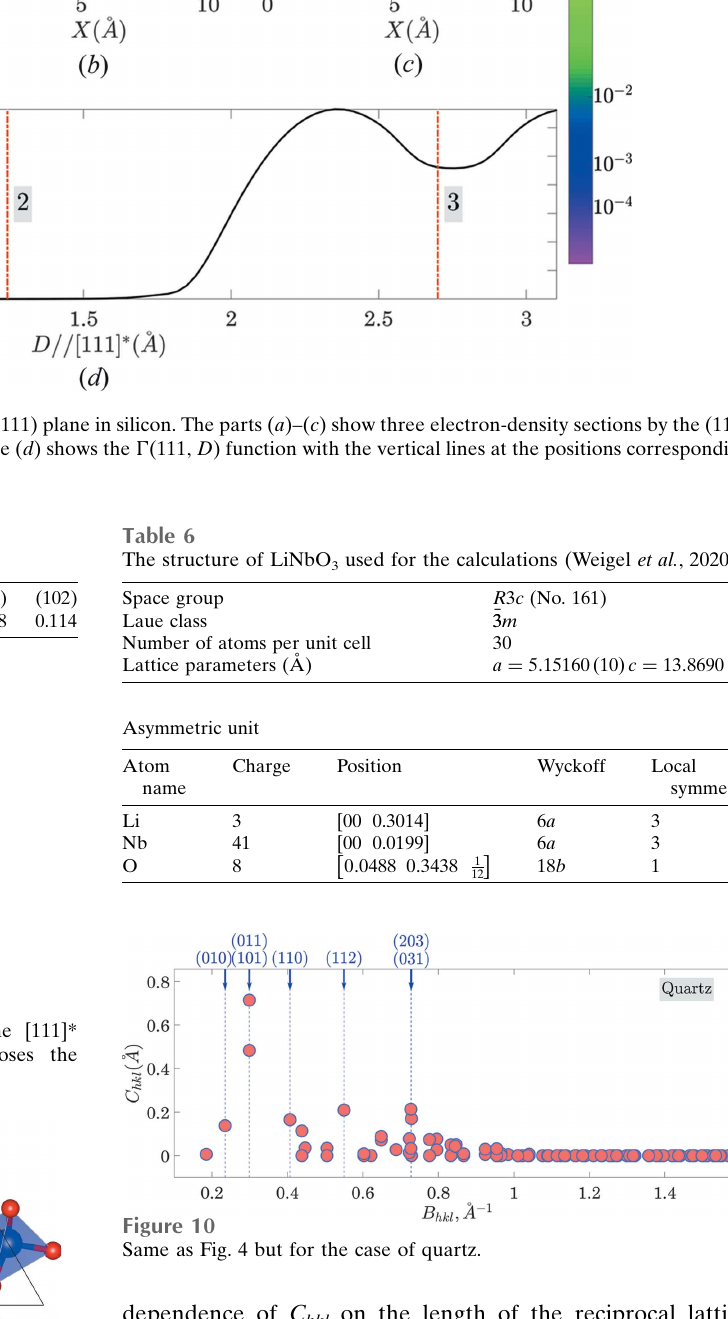
using hkl of hkl